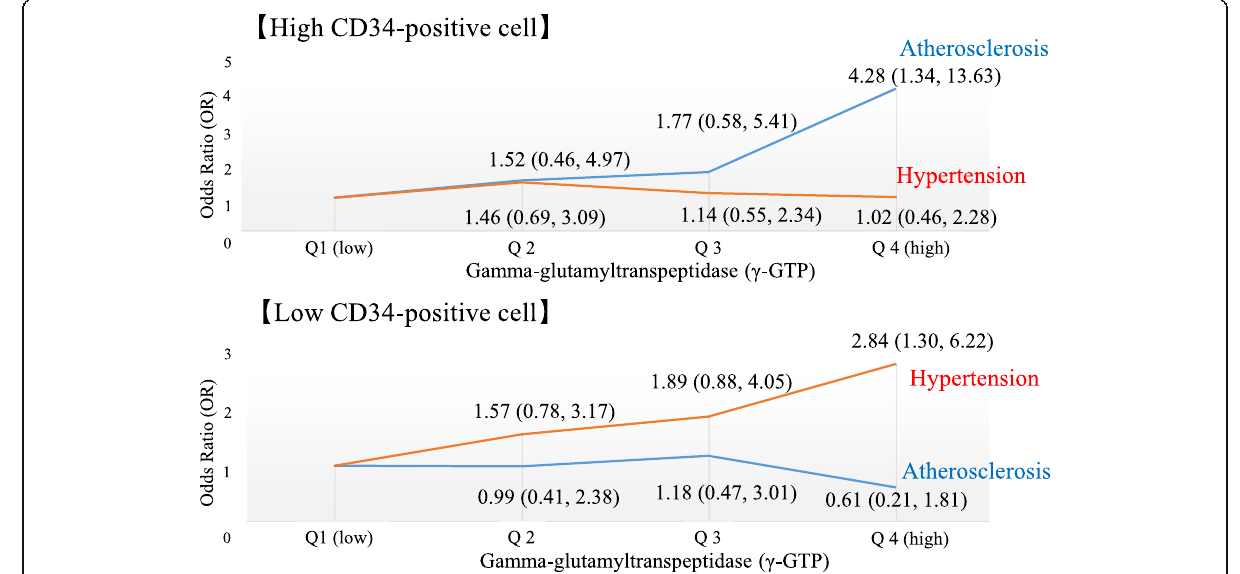
Fig. 1 Associations among γ -GTP, hypertension, and atherosclerosis based on levels of CD34-positive cells [27]